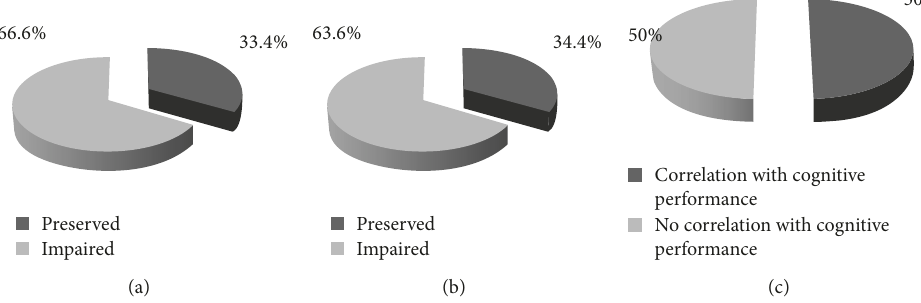
Figure 1: Proportions of preserved and impaired performance in decisions under risk tasks (a) and under ambiguity (b). Proportion of measurements showing a correlation to the performance in other cognitive tasks